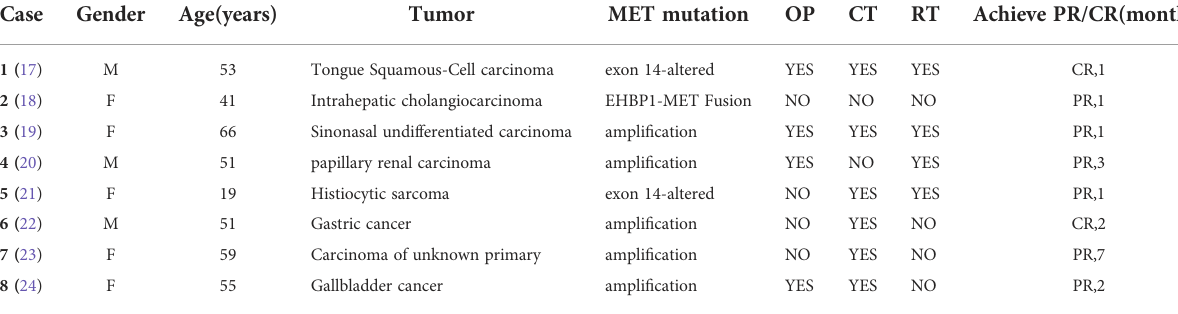
TABLE 1 The excellent response to crizotinib in some rare tumor with MET mutation.